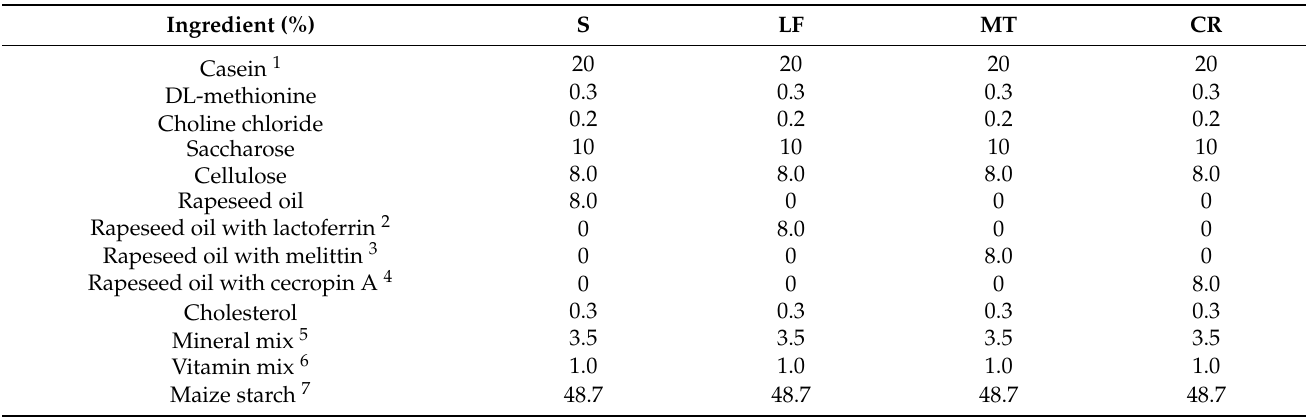
Table 1. Composition of control (S) and experimental diets supplemented with lactoferrin (LF), melittin (MT) or cecropin A